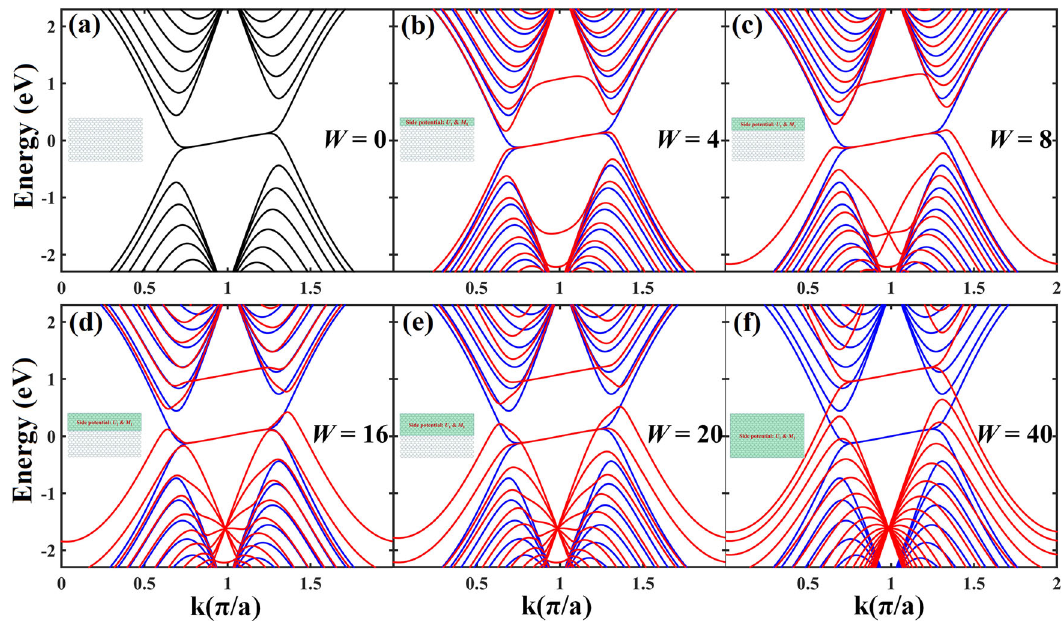
Fig. 5 The variation of energy band structure with the potential width. a W = 0. b W = 4. c W = 8. d W = 16. e W = 20. f W = 40. The ribbon width N = 40 and is de fi ned by the number of carbon atoms along the width direction. The fi xed parameters are U y